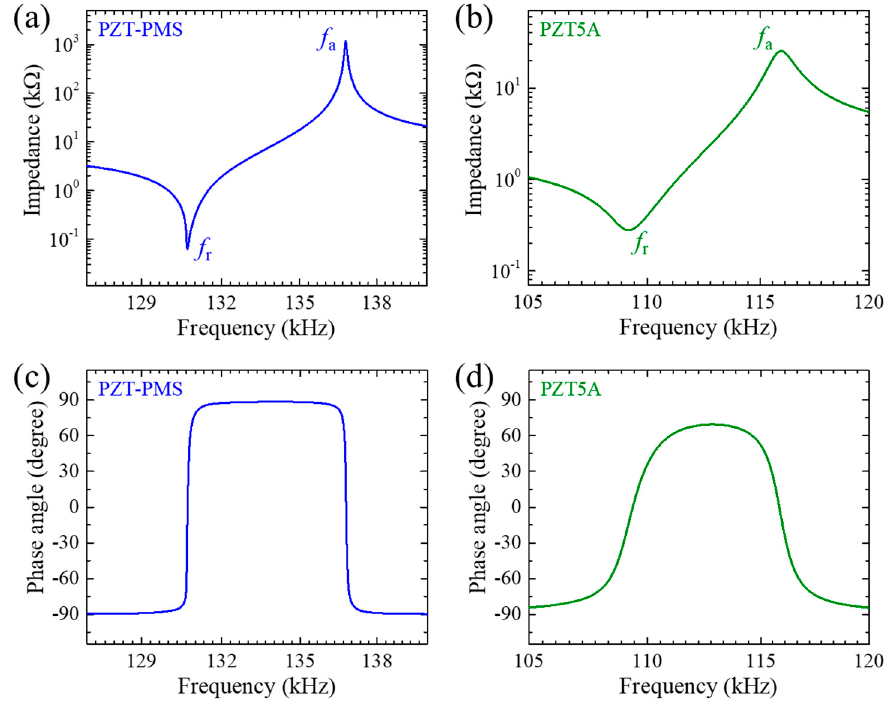
Figure2. Impedancespectraof31-modepiezoelectricsamples: ( a )PZT-PMSand( b )PZT5A.Phaseangle Figure 2. Impedance spectra of 31-mode piezoelectric samples: ( a ) PZT-PMS and ( b ) PZT5A. Phase spectra of 31-mode piezoelectric samples: ( c ) PZT-PMS and ( d ) angle spectra of 31-mode piezoelectric samples: ( c ) PZT-PMS and ( d ) PZT5A. Table 1. Piezoelectric charge coefficient ( d 31 ), piezoelectric voltage coefficient ( g 31 ), electromechanical coupling coefficient ( k 31 ), mechanical quality factors at the resonance frequency ( Q m at f r ) and anti- resonance frequency ( Q m at f a ), dielectric constant ( ε 33T / ε 0 ), and dissipation factor (tan δ ) of 31-mode PZT-PMS and PZT5A ceramics. d 31 (pCN − 1 )